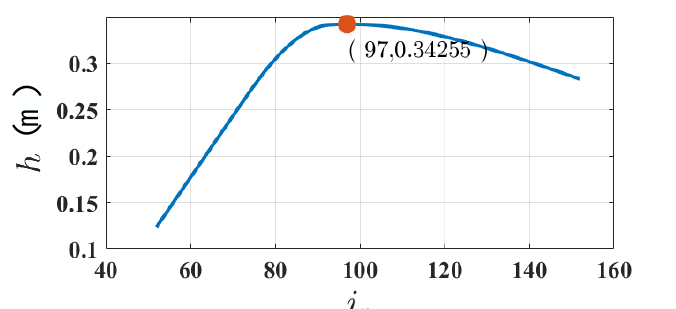
Figure 5. With the same motor and model, different reduction ratio leads to different jump height. When the same initial state X 0 = ( − 75 ◦ , 150 ◦ , − 75 ◦ , 0, 0, 0) is determined, the relationship between h and i r can be